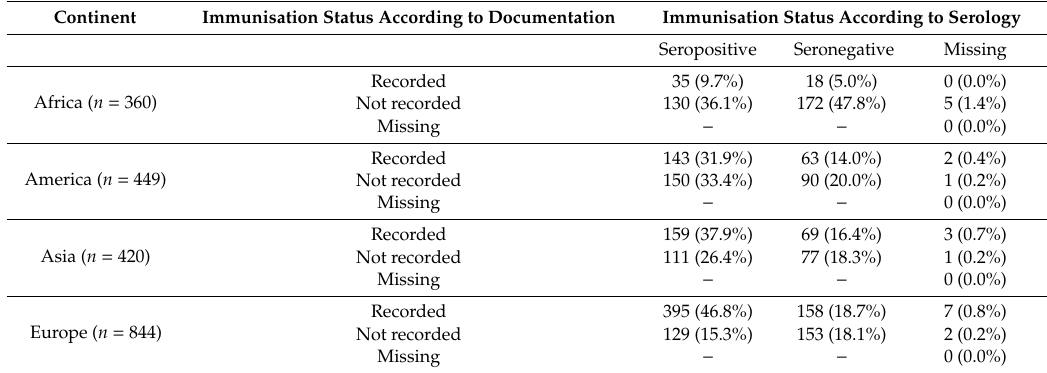
Table A4. Comparison between immunisation status of IAC reported in the documentation and serology for hepatitis B, by continent of origin.